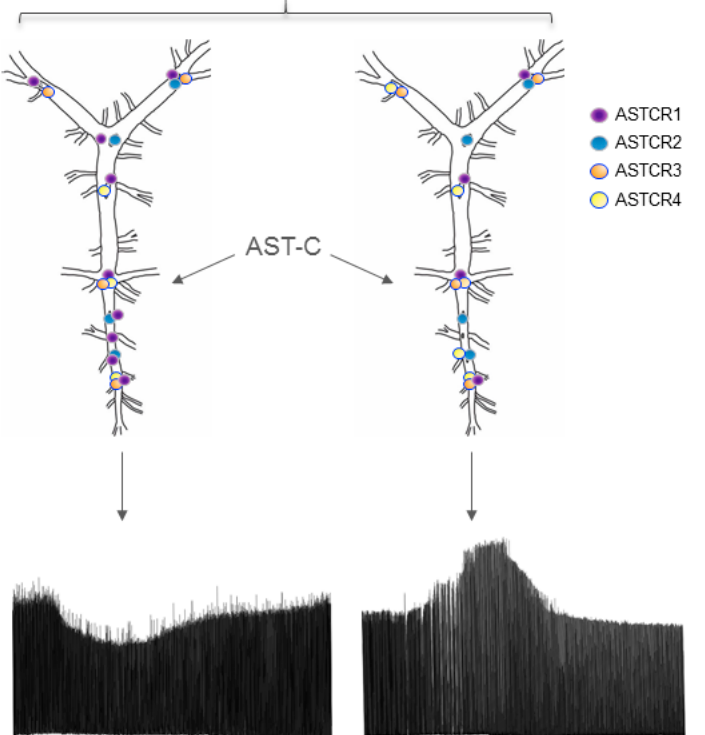
Figure 9. Differential receptor distribution partially explains individual variation in response to AST-C. This schematic shows two different cardiac ganglia (CG) with differential receptor expression; importantly, the CG on the left has a higher expression of ASTCR1 than the CG on the right. As explained by the correlation with physiological response, the CG with higher ASTCR1 expression responds to AST-C with a decrease in contraction amplitude, while the CG with lower ASTCR1 expression responds to AST-C with an increase in contraction amplitude. Notably, there is also a nonsignificant correlation with the ratio of ASTCR1:ASTCR4 expression and physiological response, while ASTCR2 and ASTCR3 expressions remain constant. ASTCR3 and ASTCR4 are depicted with blue lines to indicate potential intracellular, non-ligand binding functionalities.